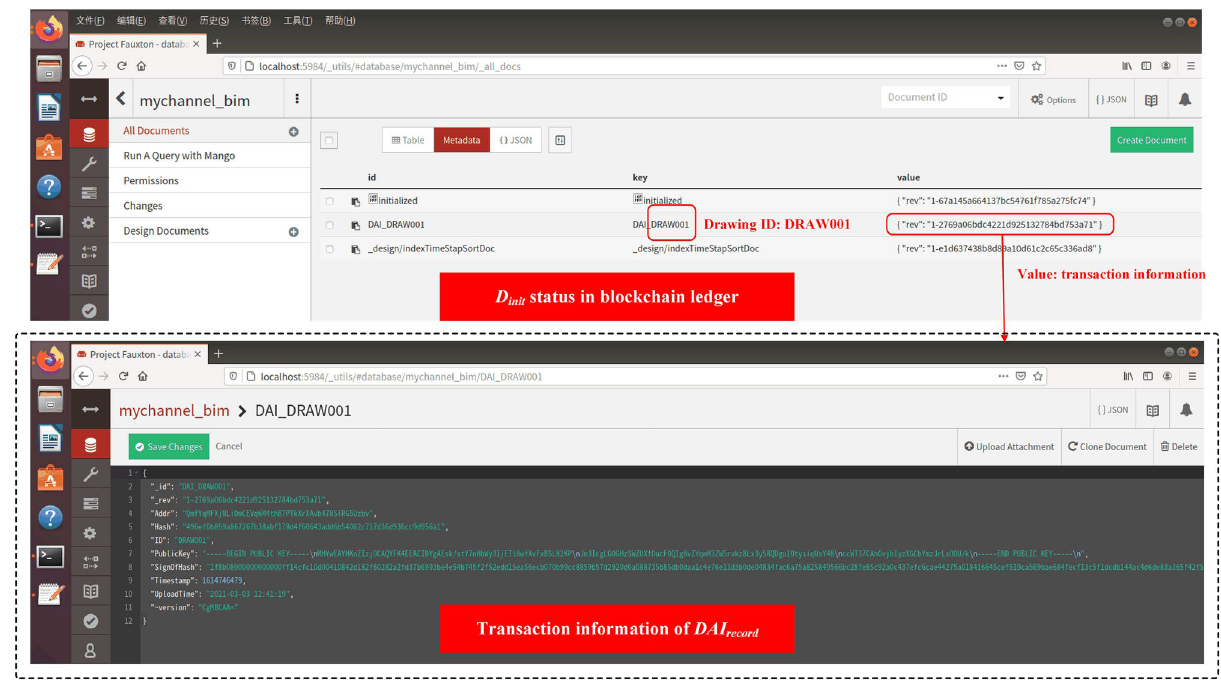
Figure 17. BIM drawing summary information in blockchain ledger.